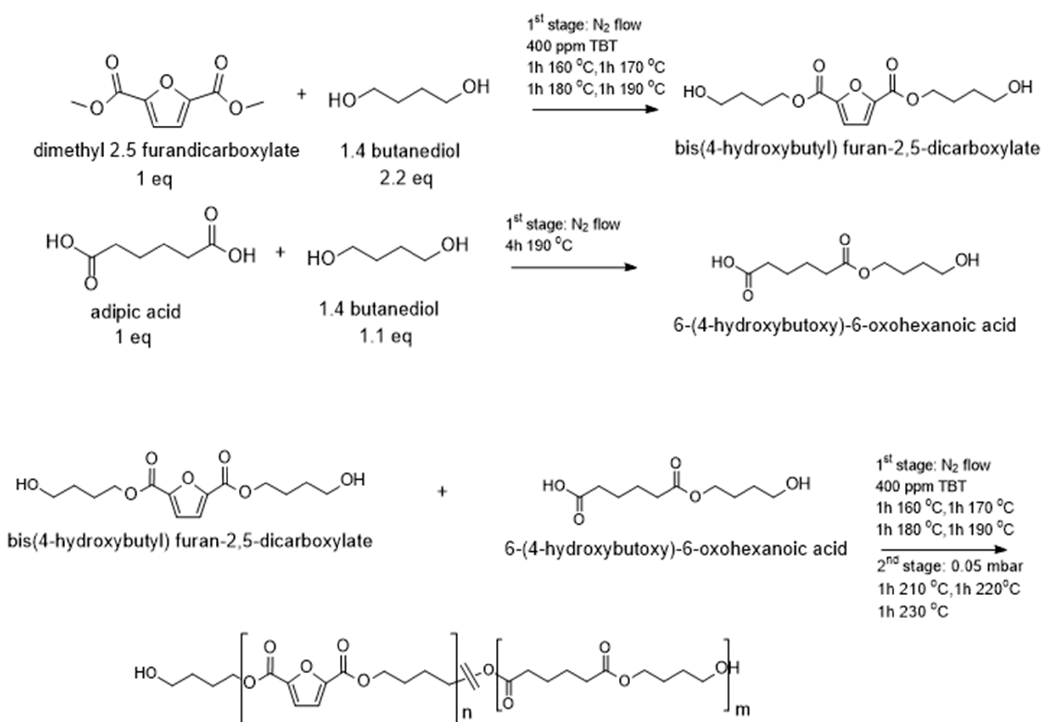
Table 1. Intrinsic viscosity values of the synthesized oligomers and